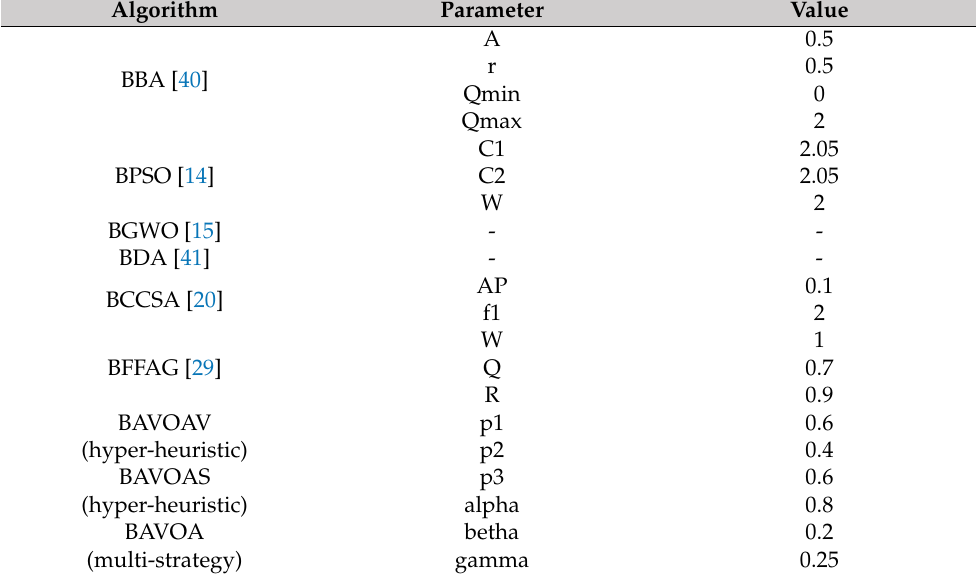
Table 2. Initial value of parameters in comparative algorithms.